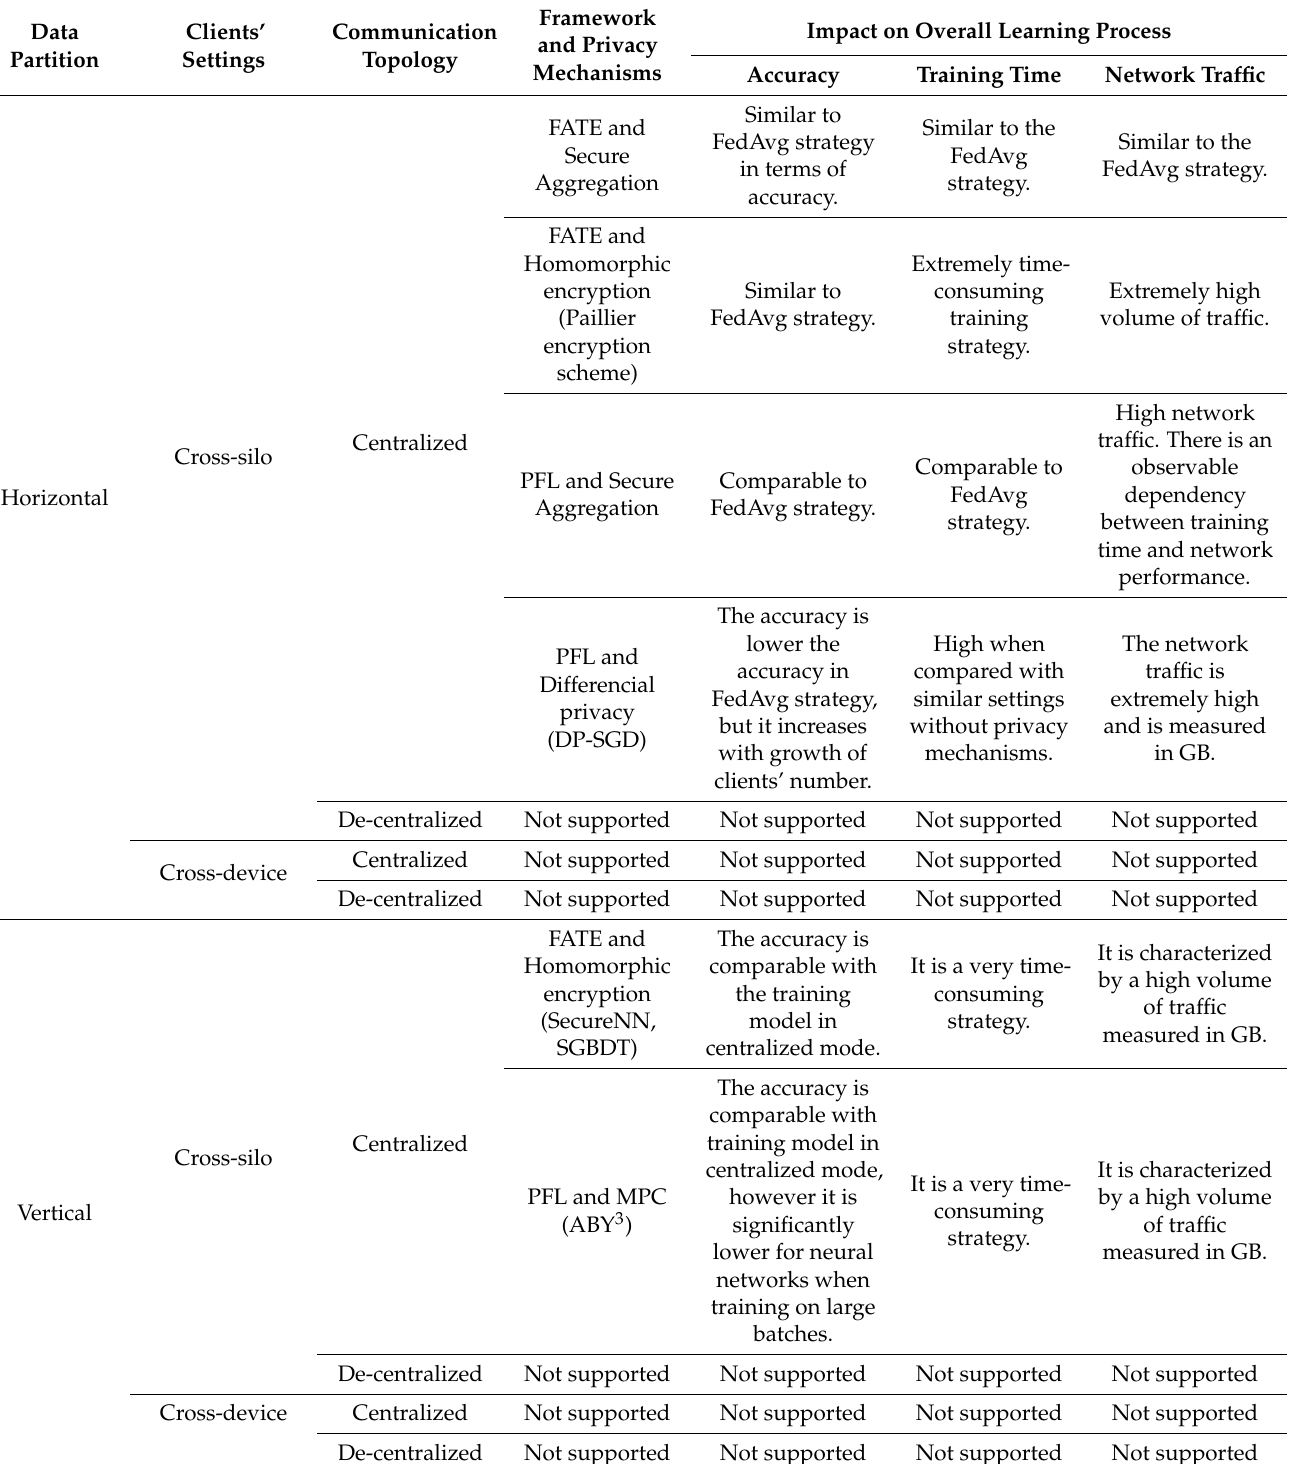
Table 8. Properties of the privacy mechanisms implemented in FATE and PFL and mapped to the FL system